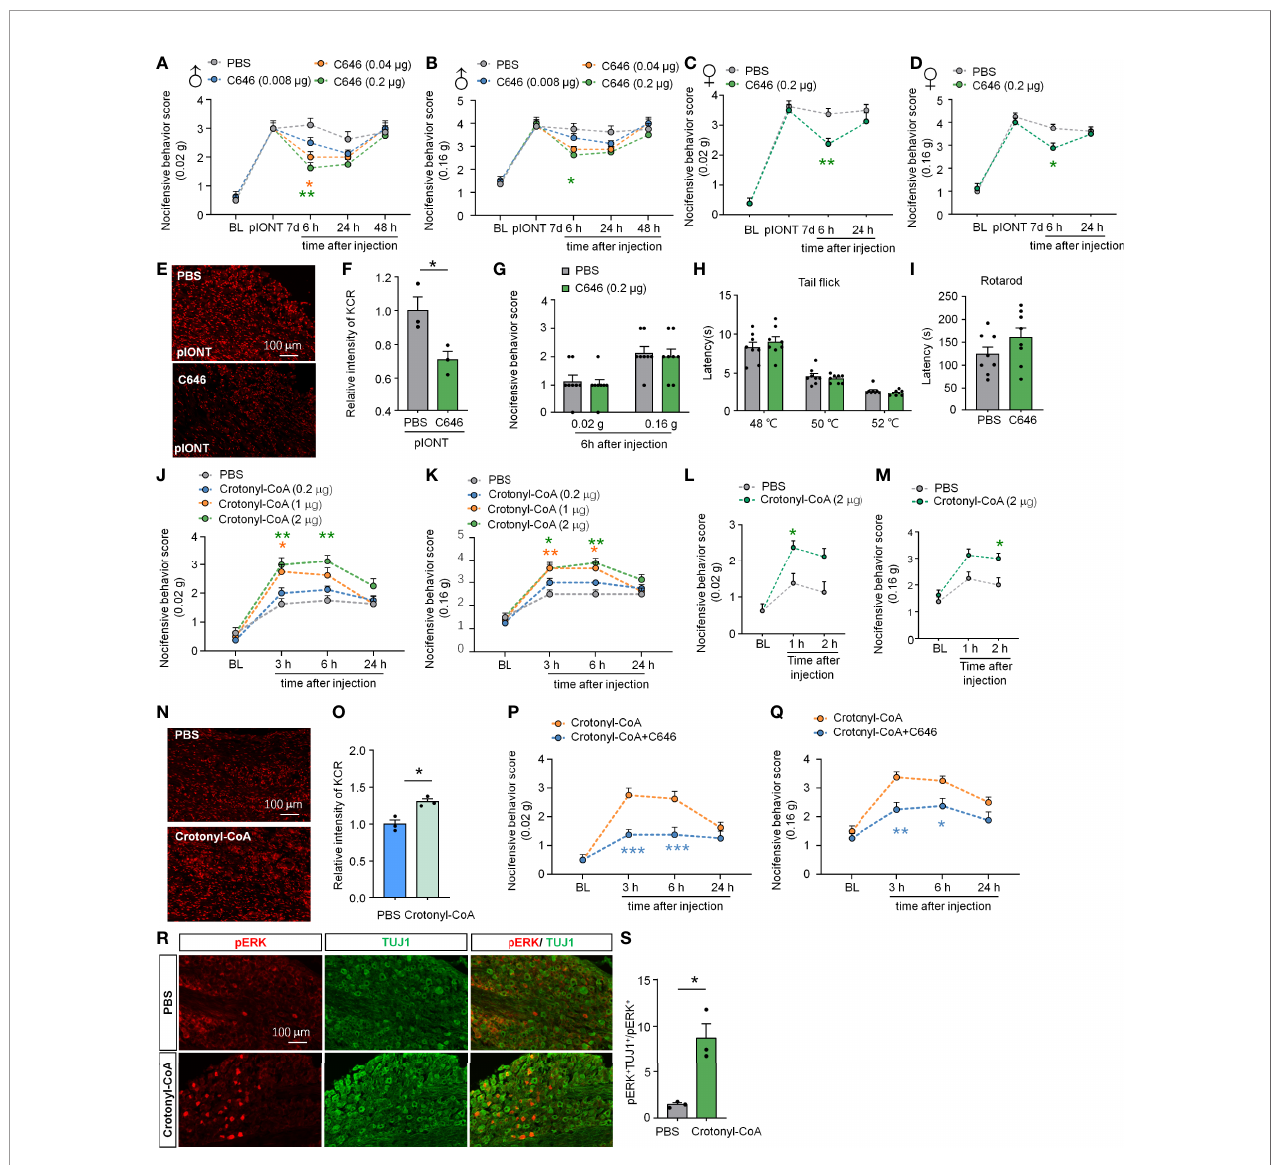
FIGURE 3 | Altering KCR levels in TG affect trigeminal neuropathic pain. (A, B) Behavioral results of facial pain in mice under different intensities of mechanical stimulation (0.02 g and 0.16 g). A single dose of intra-TG injection C646 (0.04, 0.2 m g) on day 7 after pIONT signi fi cantly attenuated pIONT-induced mechanical allodynia in male mice. The different-colored lines indicate different groups and asterisks of the same color indicated their respective comparison with the PBS group, n = 8 mice per group, * P <0.05, ** P <0.01, Two-way RM ANOVA followed by Bonferroni ’ s test. (C, D) C646 (0.2 m g) attenuated pIONT-induced mechanical allodynia in female mice 6 hours after pIONT. N = 8 mice per group, * P <0.05, ** P <0.01, Two-way RM ANOVA followed by Bonferroni ’ s test. (E, F) Representative images and statistics of fl uorescence intensity of KCR 6 hours after intra-TG injection of PBS or C646 on pIONT mice. * P <0.05, N = 3 mice per group, 3 sections per mice, student ’ s t-test. (G – I) Mechanical hyperalgesia (G) , thermal hyperalgesia (H) , and motor coordination (I) were evaluated by von Fery, tail- fl ick test, and rotarod analysis on naive mice 6 hours after a single intra-TG injection with PBS or C646. N = 8 mice per group. (J, K) Crotonyl-CoA Lithium signi fi cantly induced facial hyperalgesia in mice in a dose-dependent manner, * P <0.05, ** P <0.01, n=8 mice in each group, Two-way RM ANOVA followed by Bonferroni ’ s test. (L, M) Crotonyl-CoA Lithium signi fi cantly induced facial hyperalgesia in mice 1-2 hours postinjection. * P <0.05, n=8 mice in each group, Two-way RM ANOVA followed by Bonferroni ’ s test. (N, O) Representative images and statistics of fl uorescence intensity of KCR 6 hours after intra-TG injection of PBS or Crotonyl-CoA Lithium on naive mice. * P <0.05, N = 3 mice per group, 3 sections per mice, student ’ s t-test. (P, Q) C646 signi fi cantly attenuated Crotonyl-CoA-induced mechanical allodynia when C646 and Crotonyl-CoA Lithium were injected simultaneously, * P <0.05, ** P <0.01, *** P < 0.001 compared with the Crotonyl-CoA Lithium group, n=8 in each group, Two-way RM ANOVA followed by Bonferroni ’ s test. (R, S) Representative images and statistics of the number of pERK-positive cells in TG 6 hours after intra-TG injection of PBS or Crotonyl-CoA Lithium on naive mice. * P <0.05, N = 3 mice per group, 3 sections per mice, student ’ s